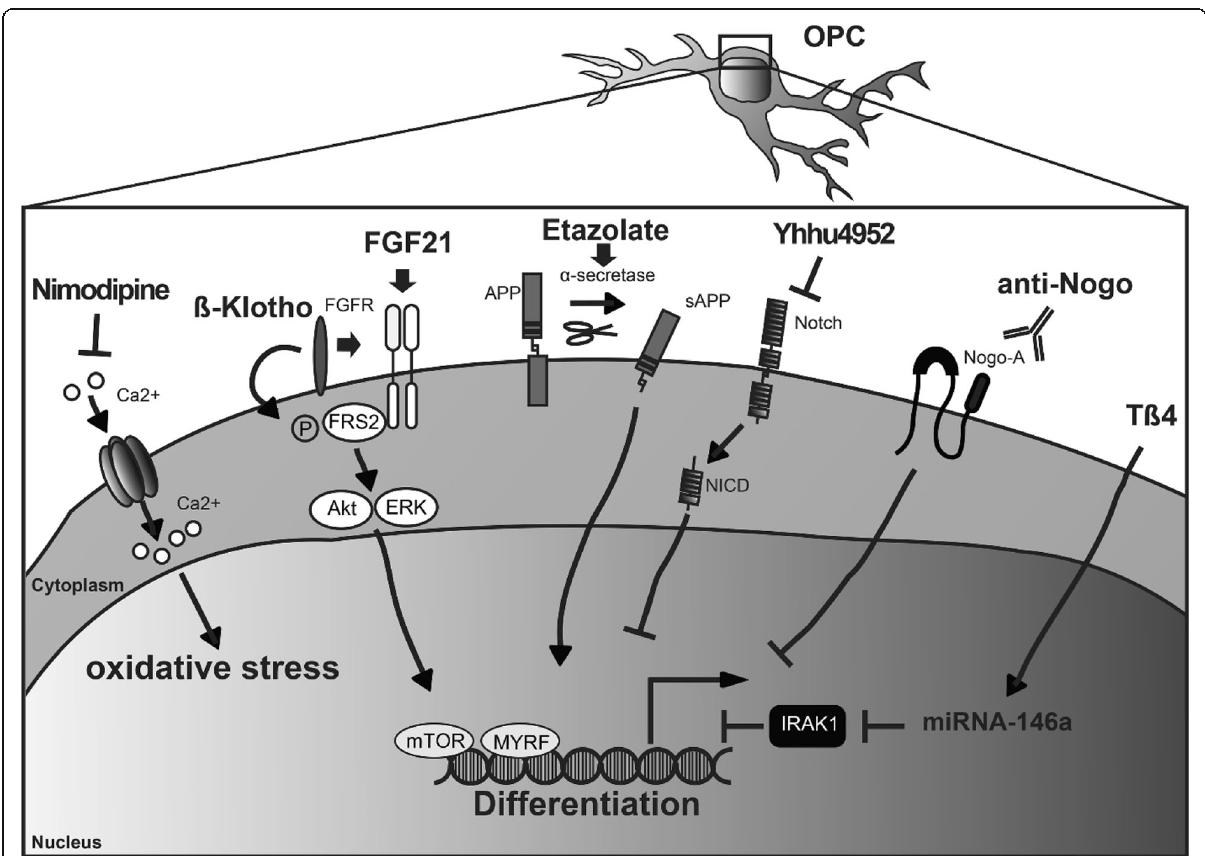
Fig. 1 Molecules affecting OPC differentiation. These molecules may represent new therapeutic strategies to exogenously promote remyelination in MS. (s)APP = (secreted ectodomain fragment of APP) ß-amyloid precursor protein; Akt = serine/threonine-specific protein kinase protein kinase B; Ca2+ = Calcium; FGF21 = fibroblast growth factor; FGFR = fibroblast growth factor receptor; FRS2 = fibroblast growth factor receptor substrate 2; IRAK1 = interleukin-1 receptor-associated kinase 1; mTOR= mammalian target of rampamycin; MYRF = myelin regulatory factor; NICD = Notch intracellular domain; OPC = oligodendroglial precursor cell; Tß4 = Thymosin